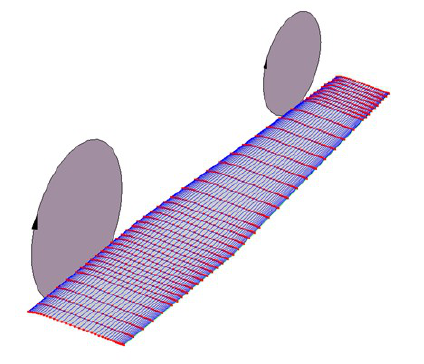
Figure 4. Computational grid used in VLM computations.